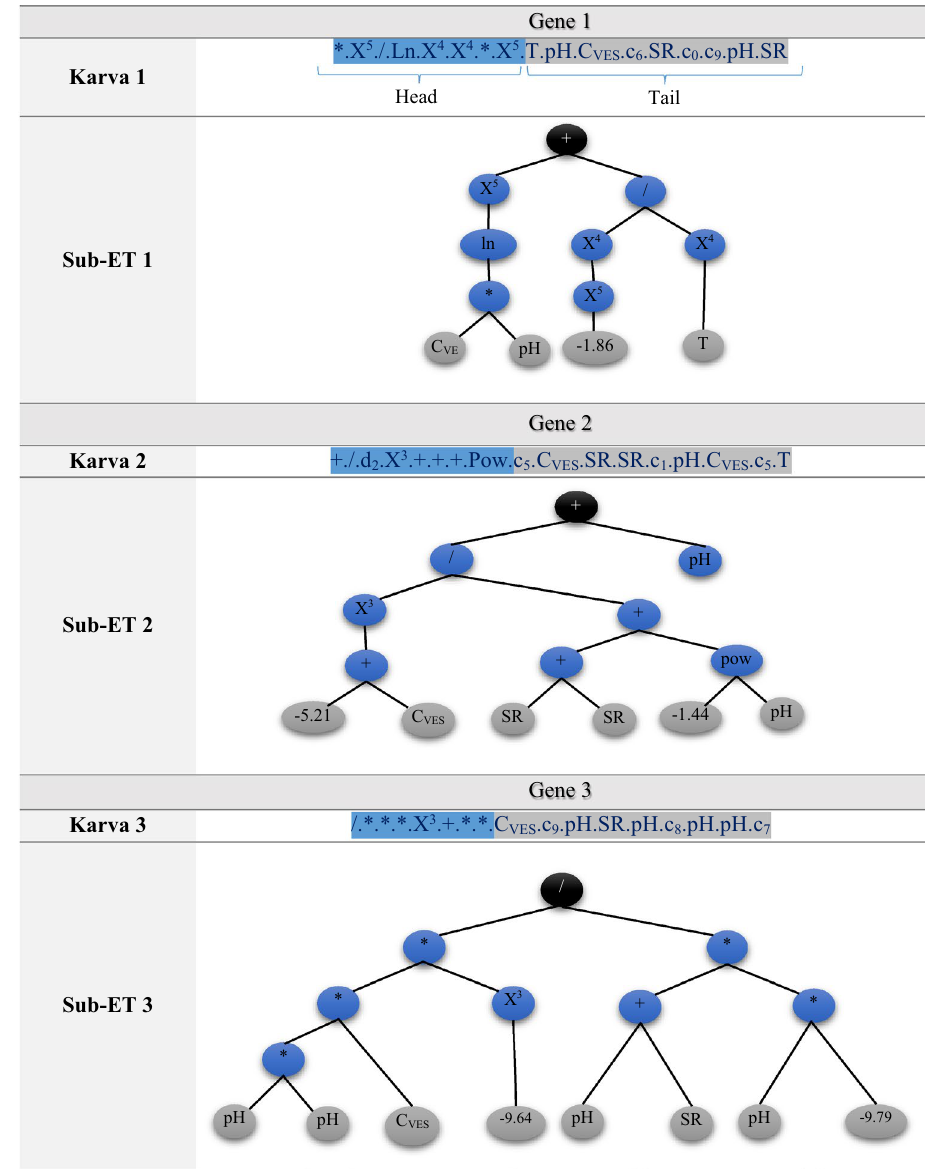
The distribution of absolute relative deviation percent (ARD%) versus pH and shear rate is portrayed in the 2D contour plots of Fig. 6. As it is shown, the main portion of this figure is covered by ARD less than 15%. This map shows the reliability of the GEP based model over a wide range of operational parameters.